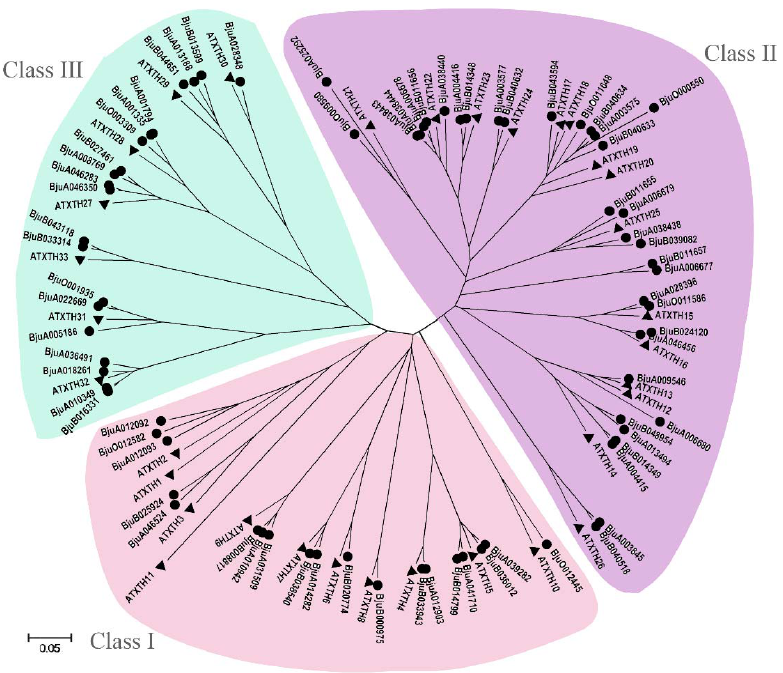
Figure 8. Phylogenetic tree of xyloglucan endotransglucosylase/hydrolase (XTHs) from B. juncea and Arabidopsis . The phylogenetic tree was constructed by the Neighbor ‐ joining method with 1000 bootstrap replications. The three groups are represented with different colors.